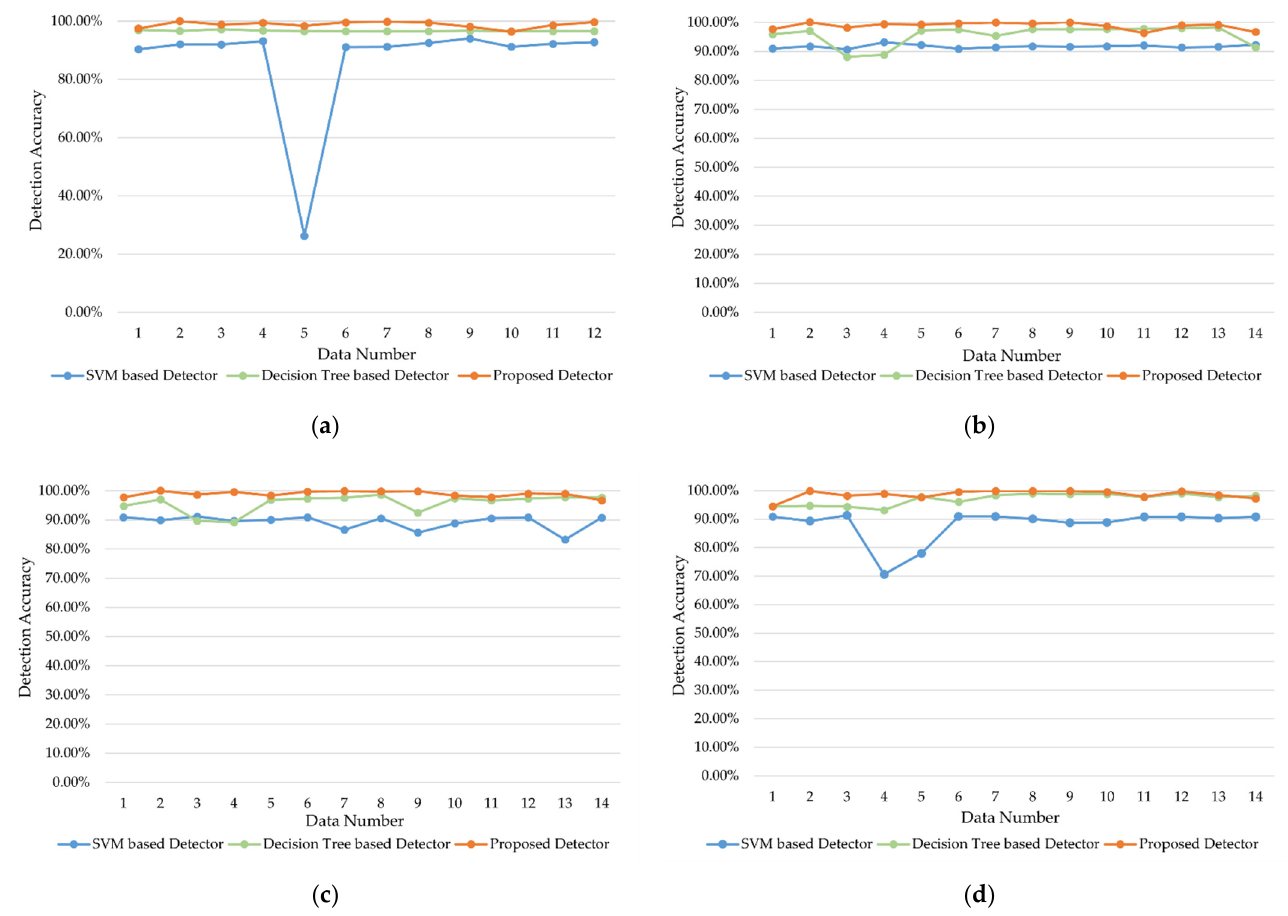
Figure 18. The influence of gcForest on detection probability of different polarization, red points in charts are the points with the highest detection probability. ( a ) HH polarization; ( b ) HV polarization; ( c ) VH polarization; ( d ) VV polarization.